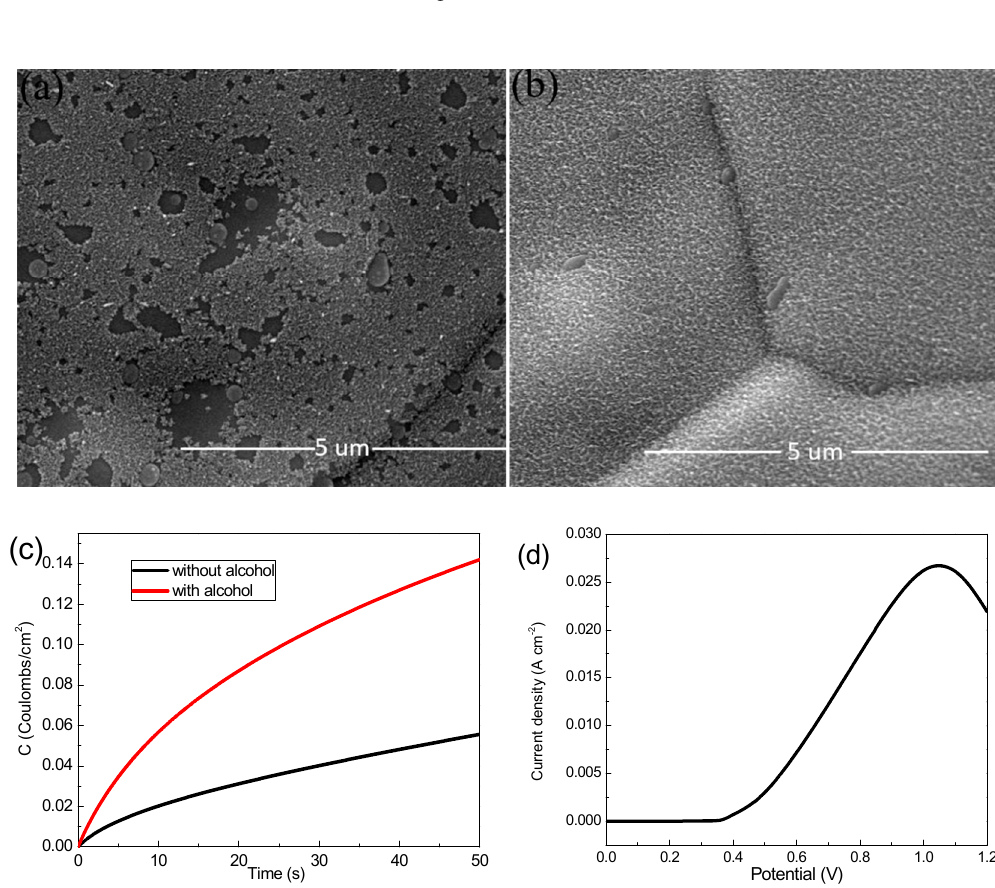
Figure 1. ( a ) Scanning electron microscope (SEM) images of samples without alcohol; ( b ) SEM images of samples with alcohol; ( c ) chronocoulometry technique curves with and without alcohol sample; ( d ) Linear sweep voltammetry (LSV) curve.